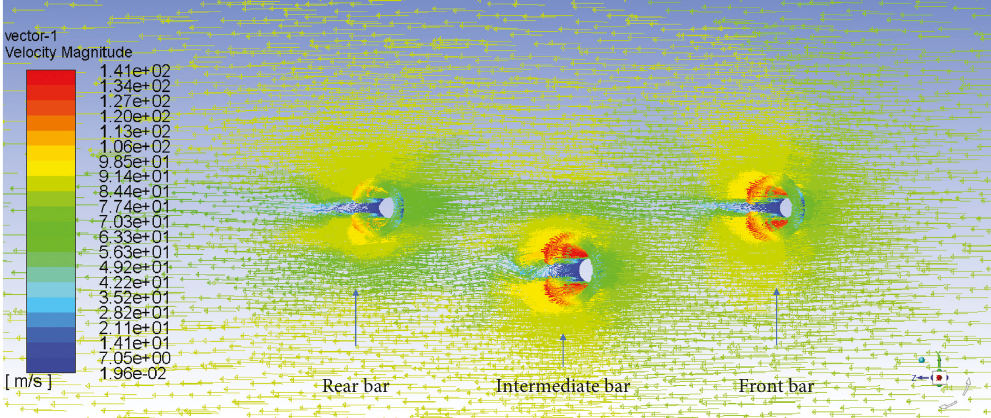
Figure 10: Vortex shedding around cylindrical panhead bars of the SSS87